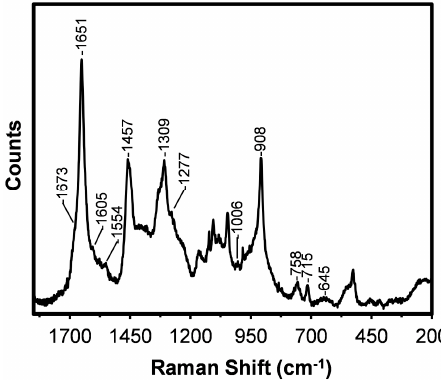
Figure 2. Raman spectrum obtained from the hand drawn (0.14 cm/s) B. terrestris silk fibre.